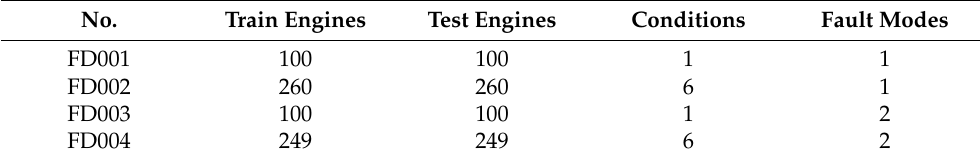
Table 1. C-MAPSS dataset.